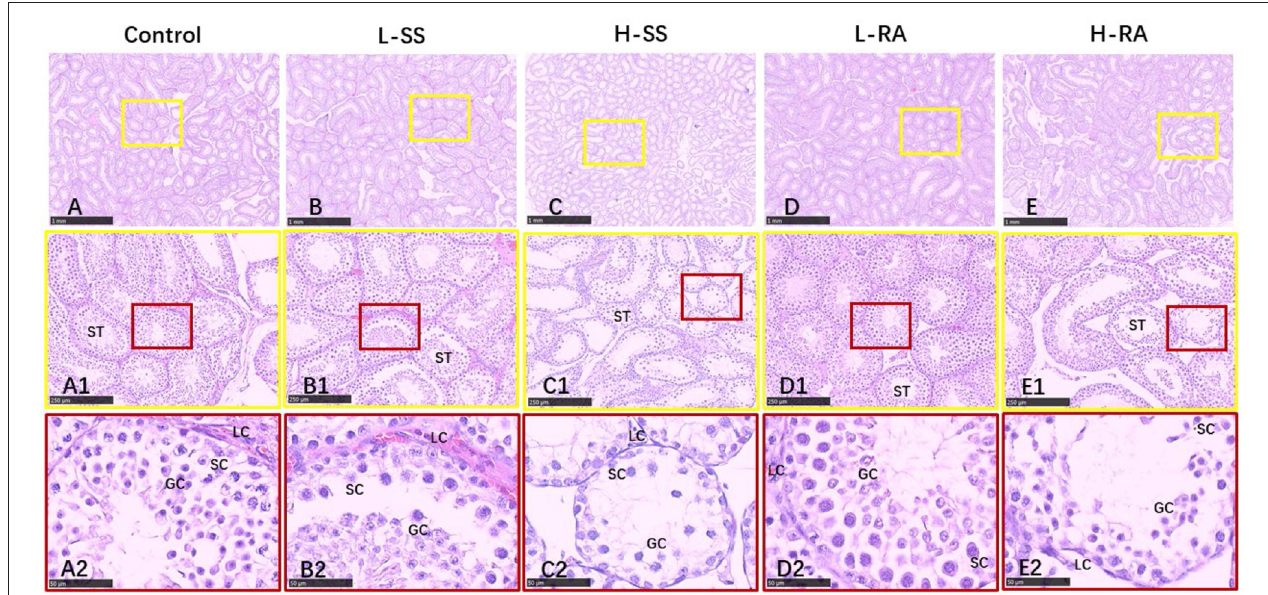
FIGURE 4 | Effect of dietary non-nutritive sweetness drinking on histologic changes in the testis of male guinea pigs. Animals in the control, L-SS, H-SS, L-RA, and H-RA groups were supplied water solution with normal water, 1.5mM sodium saccharin, 7.5mM sodium saccharin, 0.5mM rebaudioside A, and 2.5mM rebaudioside A for 28 days, respectively. Tissues were sectioned at 4 µ m and stained with H&E. Graphs in small colored square boxes are enlarged below. GC, germ cell; SC, Sertoli cell; LC, Leydig cell. Bars = 1,000 µ m (A–E) , 250 µ m (A1–E1) , and 50 µ m (A2–E2) .